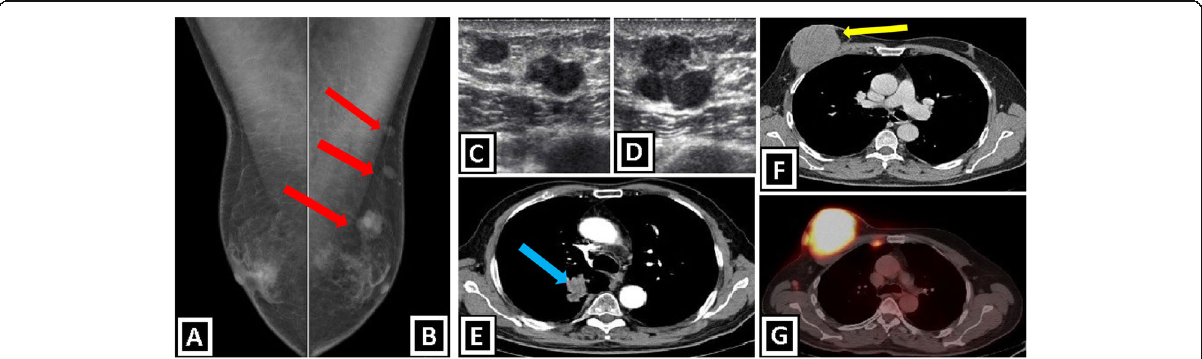
Fig. 12 Secondary malignant breast masses in males. a – e Radiological images of a 58-year-old man with lung adenocarcinoma. a , b Bilateral medio-lateral oblique mammograms show bilateral gynecomastia and three round masses in left breast (red arrows). c , d US images demonstrate macrolobulated round hypoechoic metastatic masses. e Contrast-enhanced axial CT image shows lung adenocarcinoma in left lung (blue arrow). f , g Breast involvement of diffuse large B cell lymphoma in a 63-year-old patient. Contrast enhanced axial CT image shows a circumscribed mass within left breast ( f ). PET-CT scan reveals FDG-avid masses which are consistent with lymphamatous infiltration located in not only right breast, but also right internal mammarian and axillary lymph node stations ( g